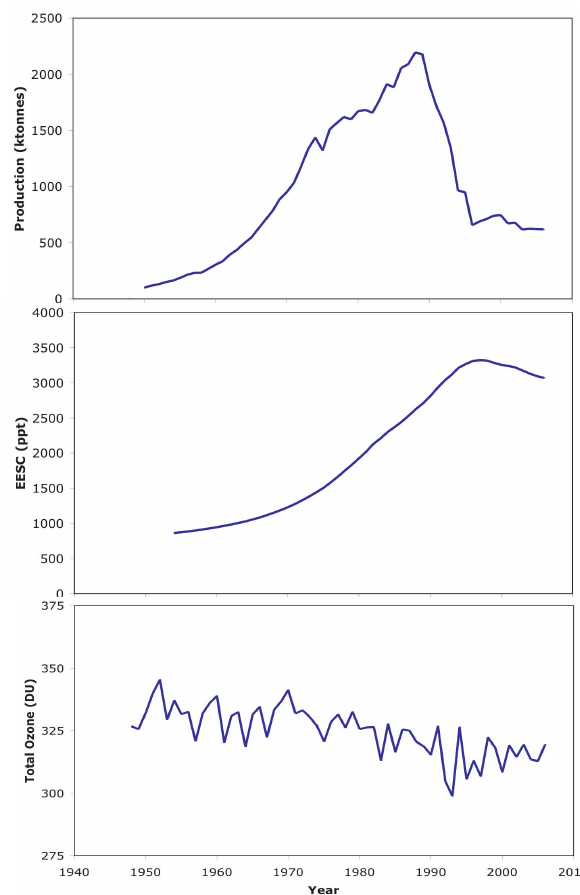
Fig. 1. Top: Global production of ODS. Middle: Ability of ODS to deplete stratospheric ozone (Equivalent Effective Stratospheric Chlorine – EESC) (solid) in comparison with a linear trend starting in 1970 (dashed). EESC is an overall measure of chemical ozone depletion taking into account the lifetimes and the chemical ozone depleting potentials of the individual chemical species. Bottom: Annual mean values of the total ozone series of Arosa (Switzer- land) and relevant processes influencing total ozone at Northern